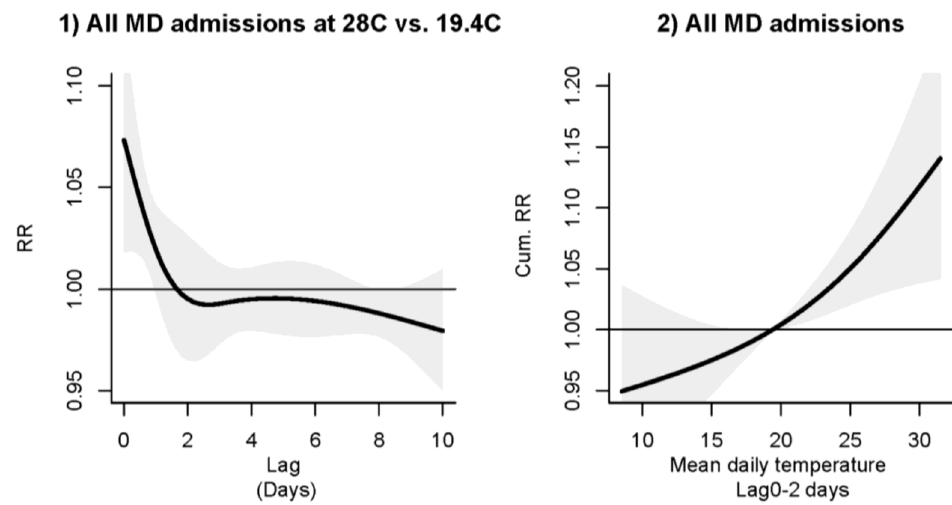
Figure 2. ( 1 ) left: RR-lag plot and ( 2 ) right: RR-temperature ( ◦ C) plot for overall mental disorders (MD) admissions, in Hong Kong, 2002–2011. Table 4. Regression results for temperature with overall mental-disorders admissions and subgroup admissions in Hong Kong, 2002–2011. 95% Confidence Interval Sub-Group RR Lower